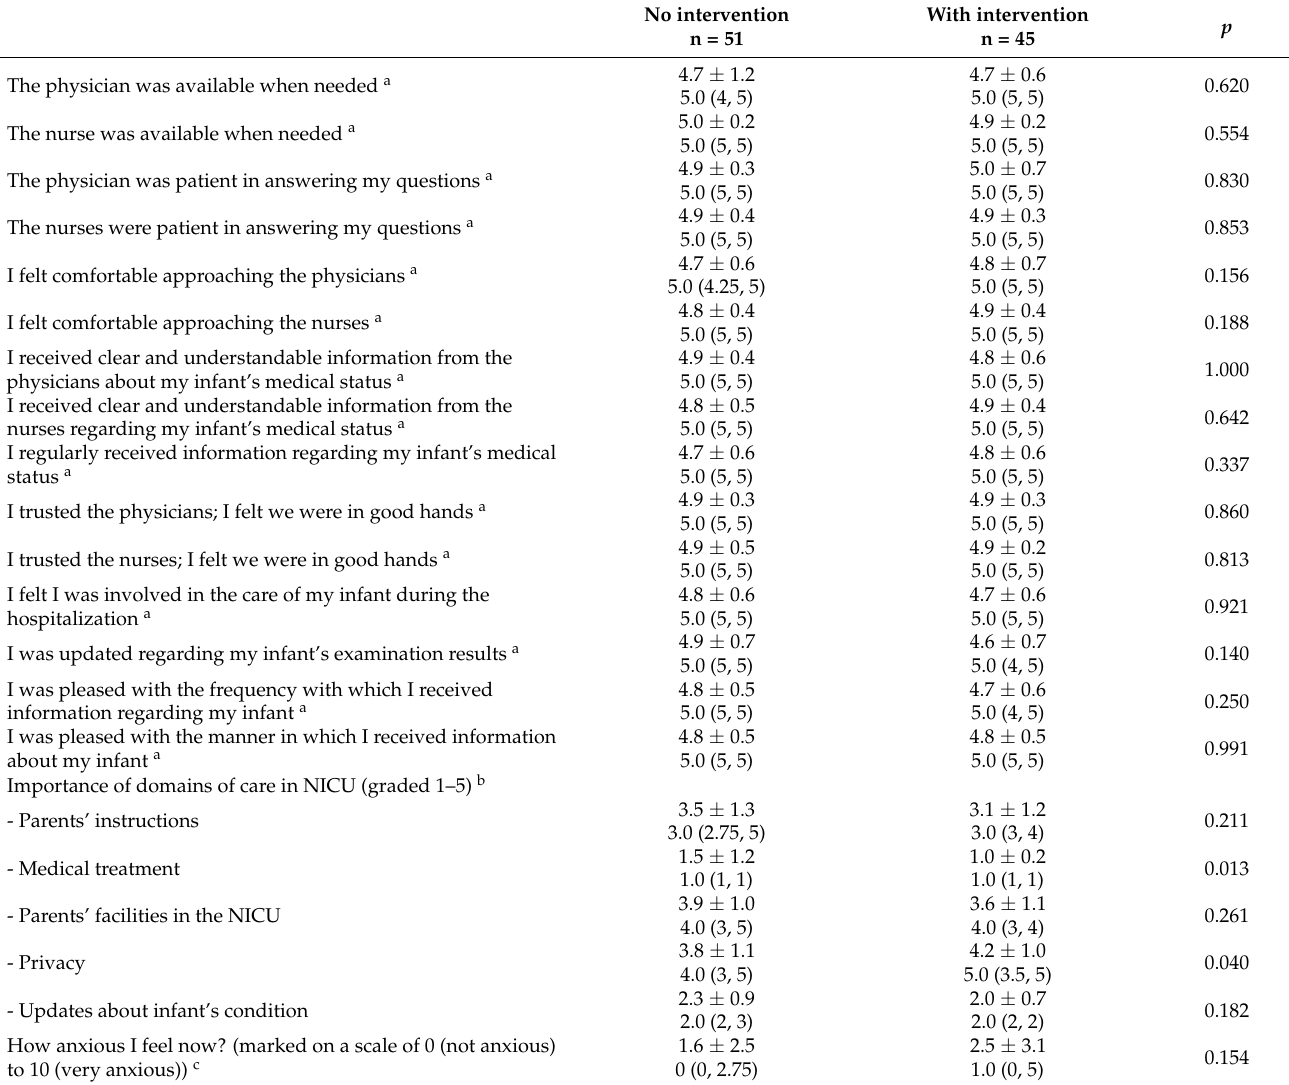
Table 2. Parents’ satisfaction questionnaire scores in the study and control groups.